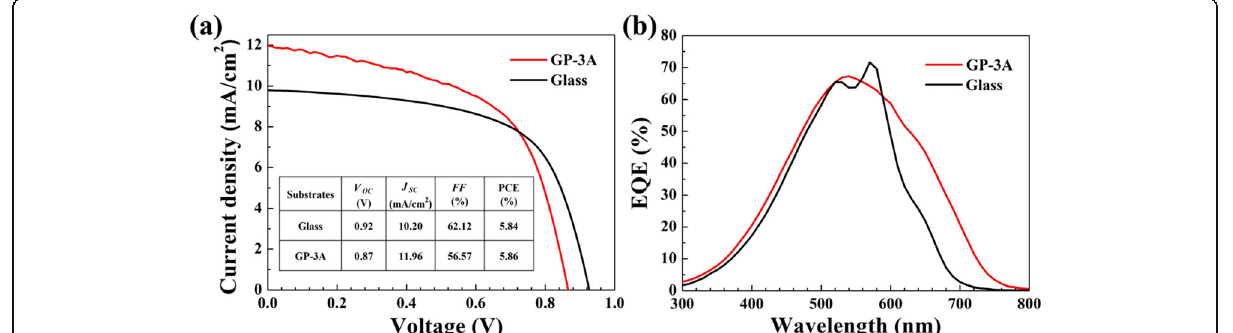
Fig. 6 a J - V curves and b EQE measurements of a -Si:H devices based on the GP-3 and glass